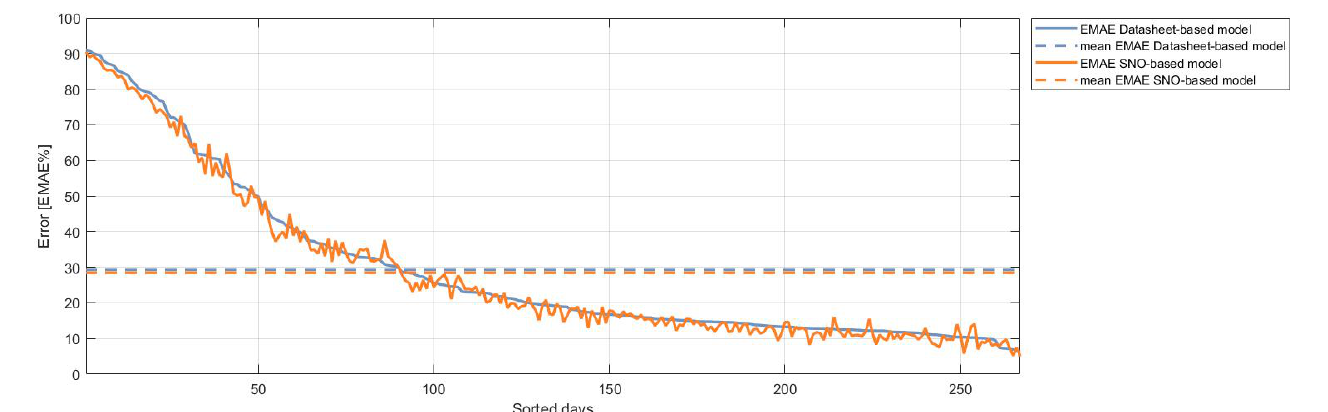
Figure 7. EMAE comparison between the two physical models, in which the days are sorted according to the error value.